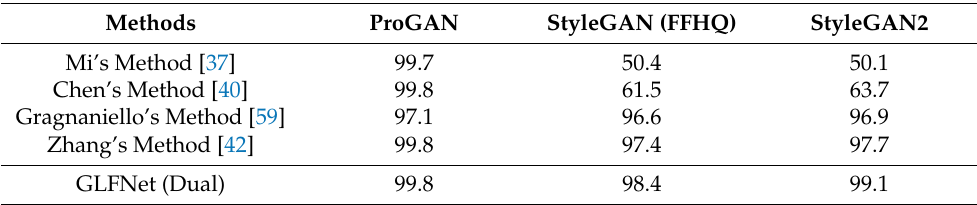
Table 8. Comparison of classification accuracy (%) with state-of-the-art methods.